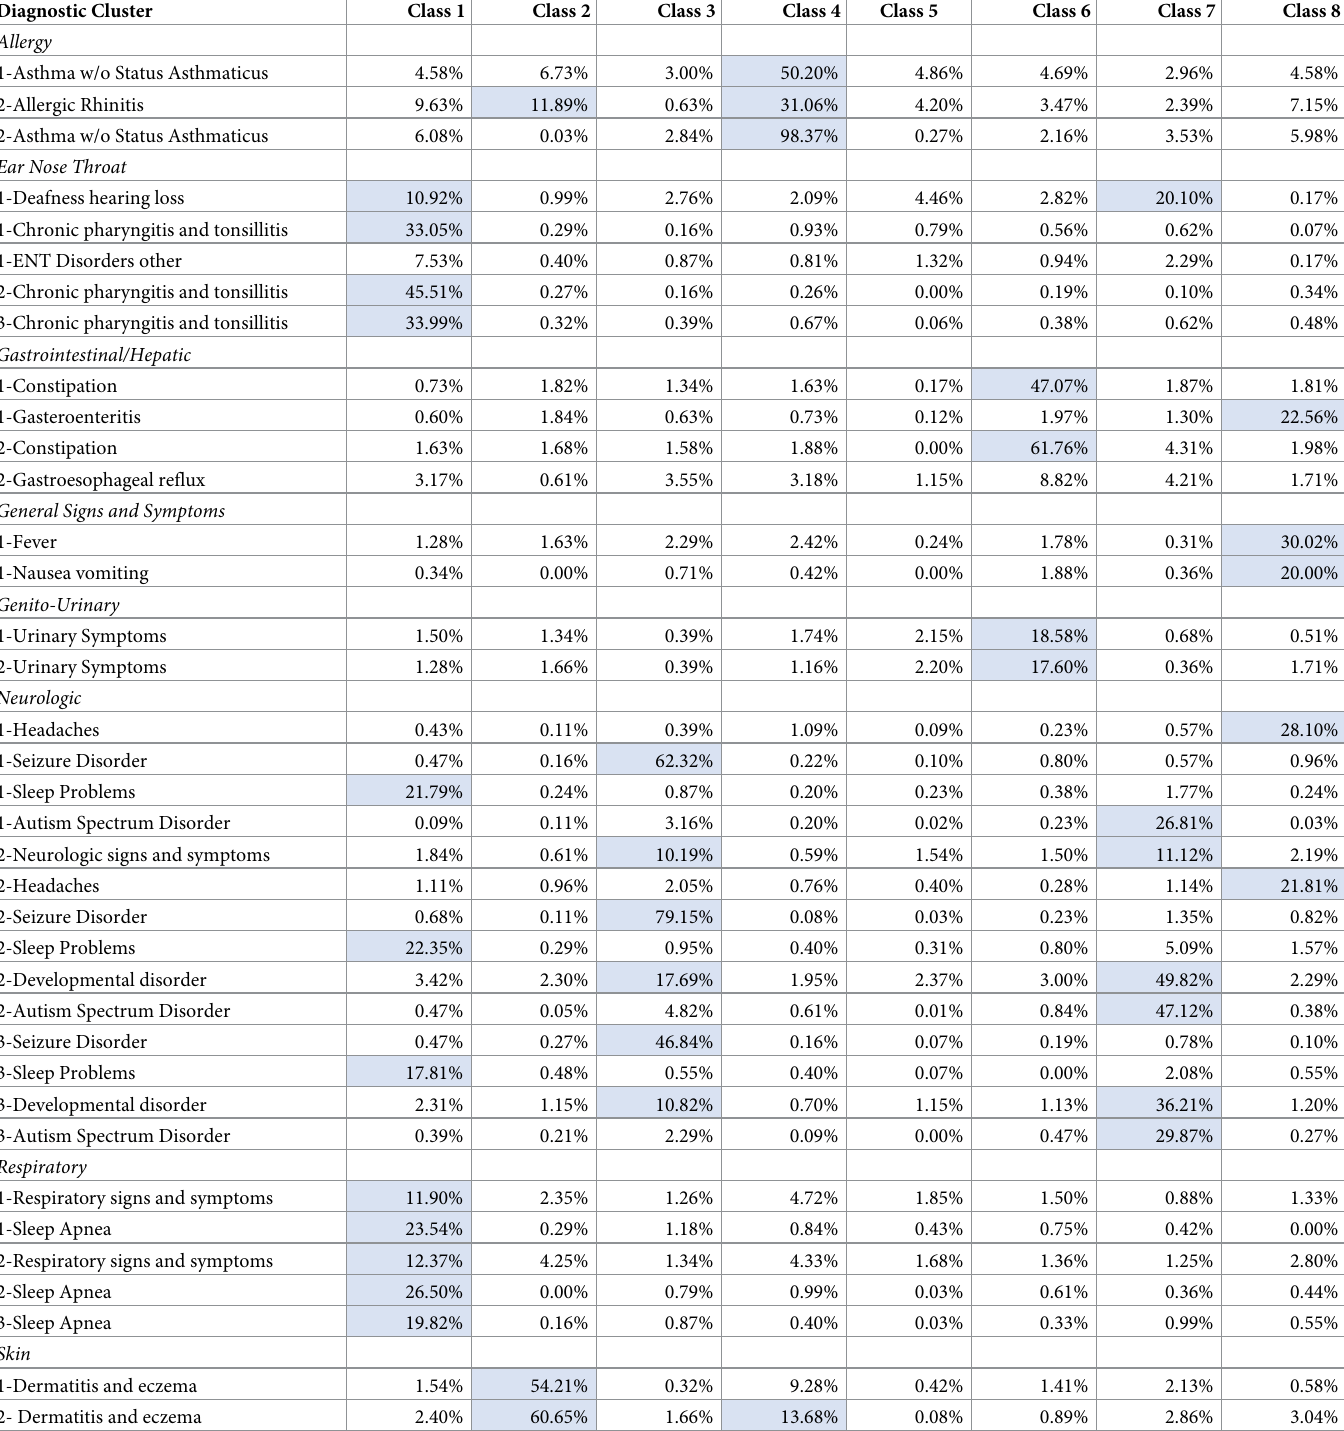
Table 2. Prevalence Rate of Diagnoses by Class �